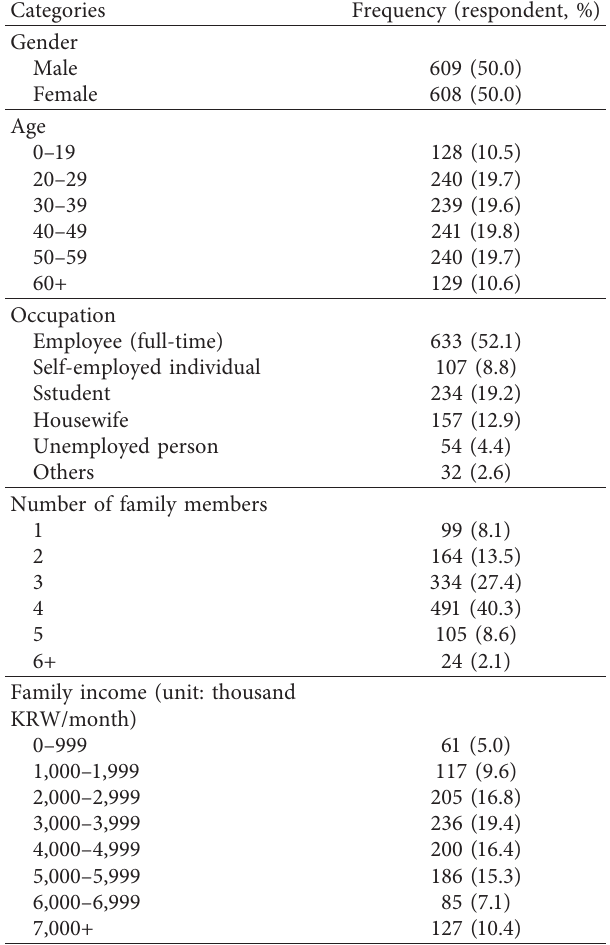
Table 5: Interviewees’